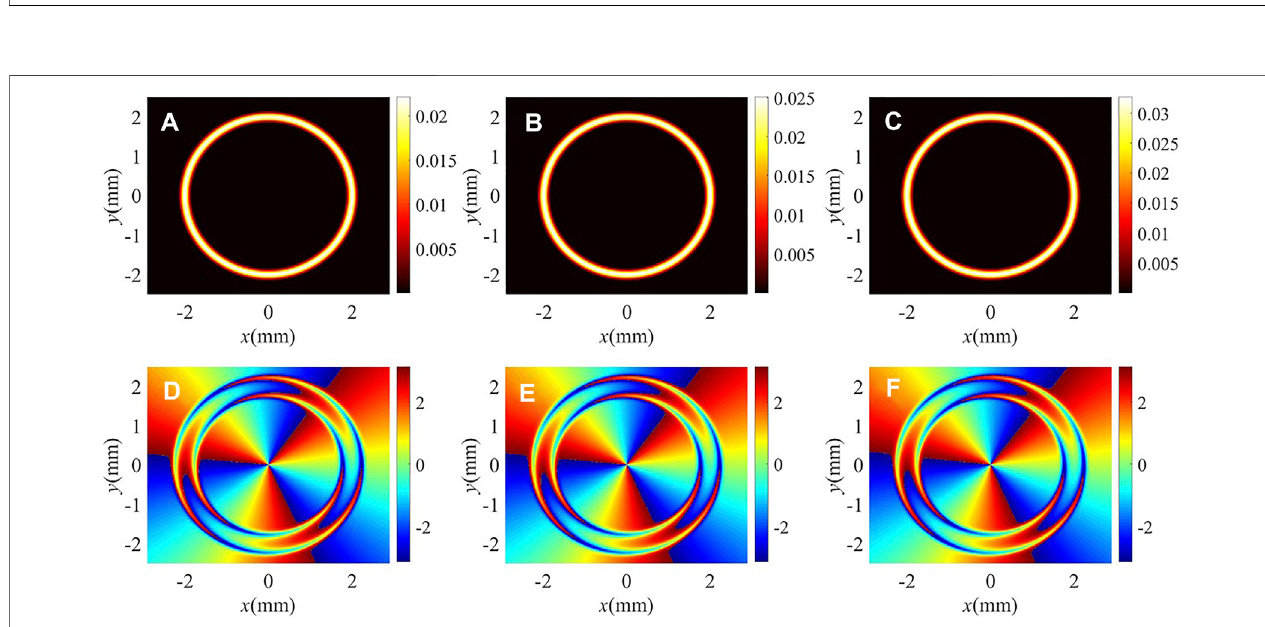
FIGURE 5 | Real and imaginary parts of (A – C) Q and (D – F) K + versus radius r for different probe detuning Δ p : (A,D) Δ p = − 4 meV; (B,E) Δ p = 4 meV; (C,F) Δ p = 8 meV. Other parameters are the same as in Figure 2C .